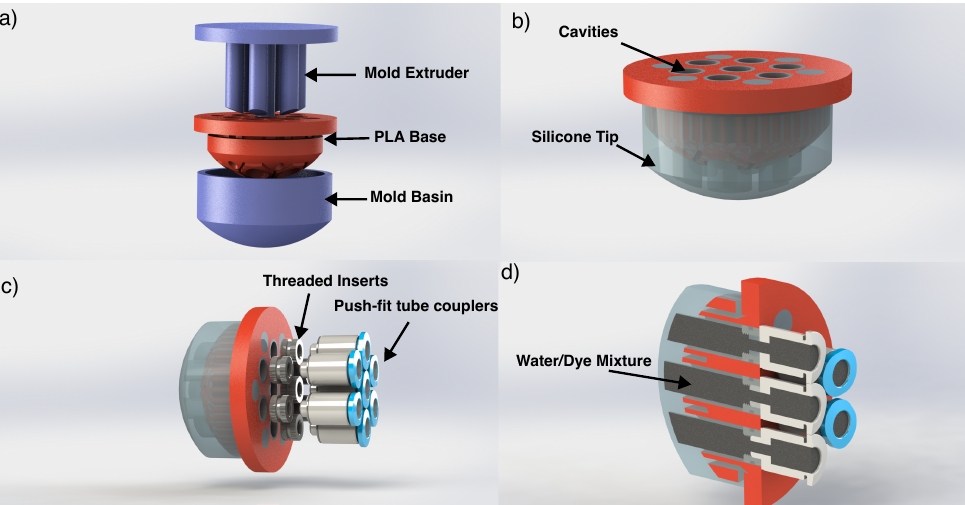
Figure 1. CAD views of the ESPRESS.0 fabrication process. ( a ) An uncured silicone mixture is added to the mould basin, the base and extruder are then clamped onto the basin. The mould parts (blue) may be used to fabricate another ESPRESS.0 tip. ( b ) The silicone cures in the negative space, leaving cavities in the tip. ( c ) The tip is prepared for watertight coupling to 2 mm OD tubing. ( d ) Cross-section showing the cavities filled with the water/dye mixture before silicone tubing is attached.